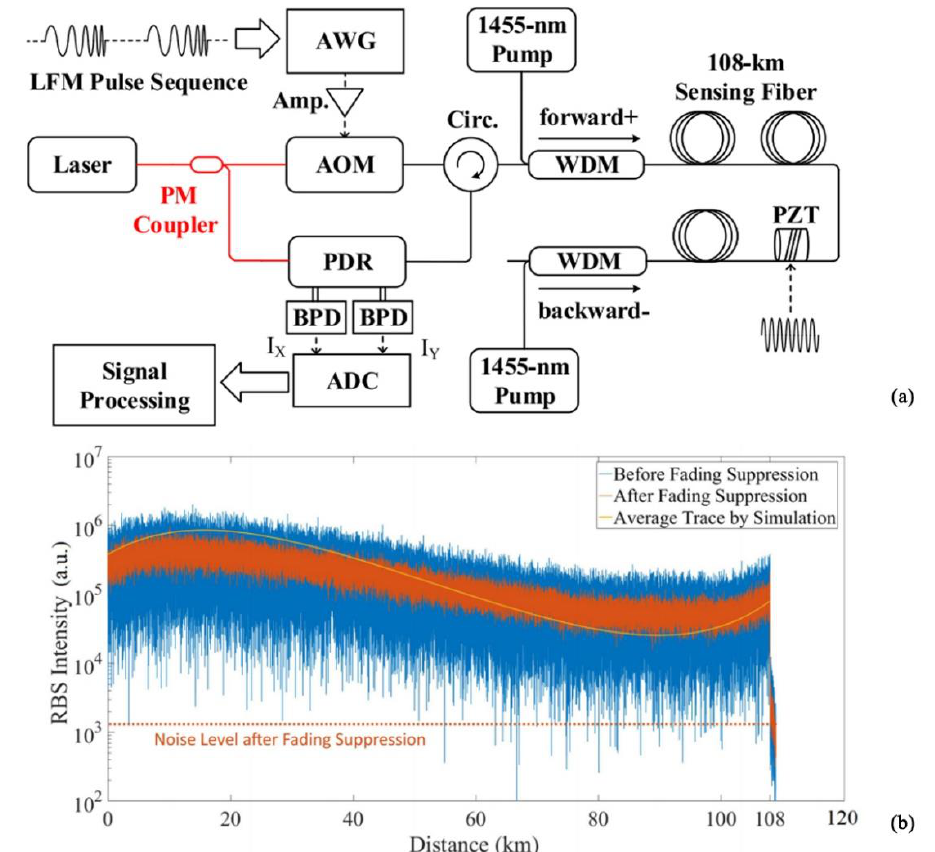
Figure 17. ( a ) Experimental setup. ( b ) RBS intensity – distance trace of 108 km sensing fiber with bi-directional first-order distributed Raman amplification [69].